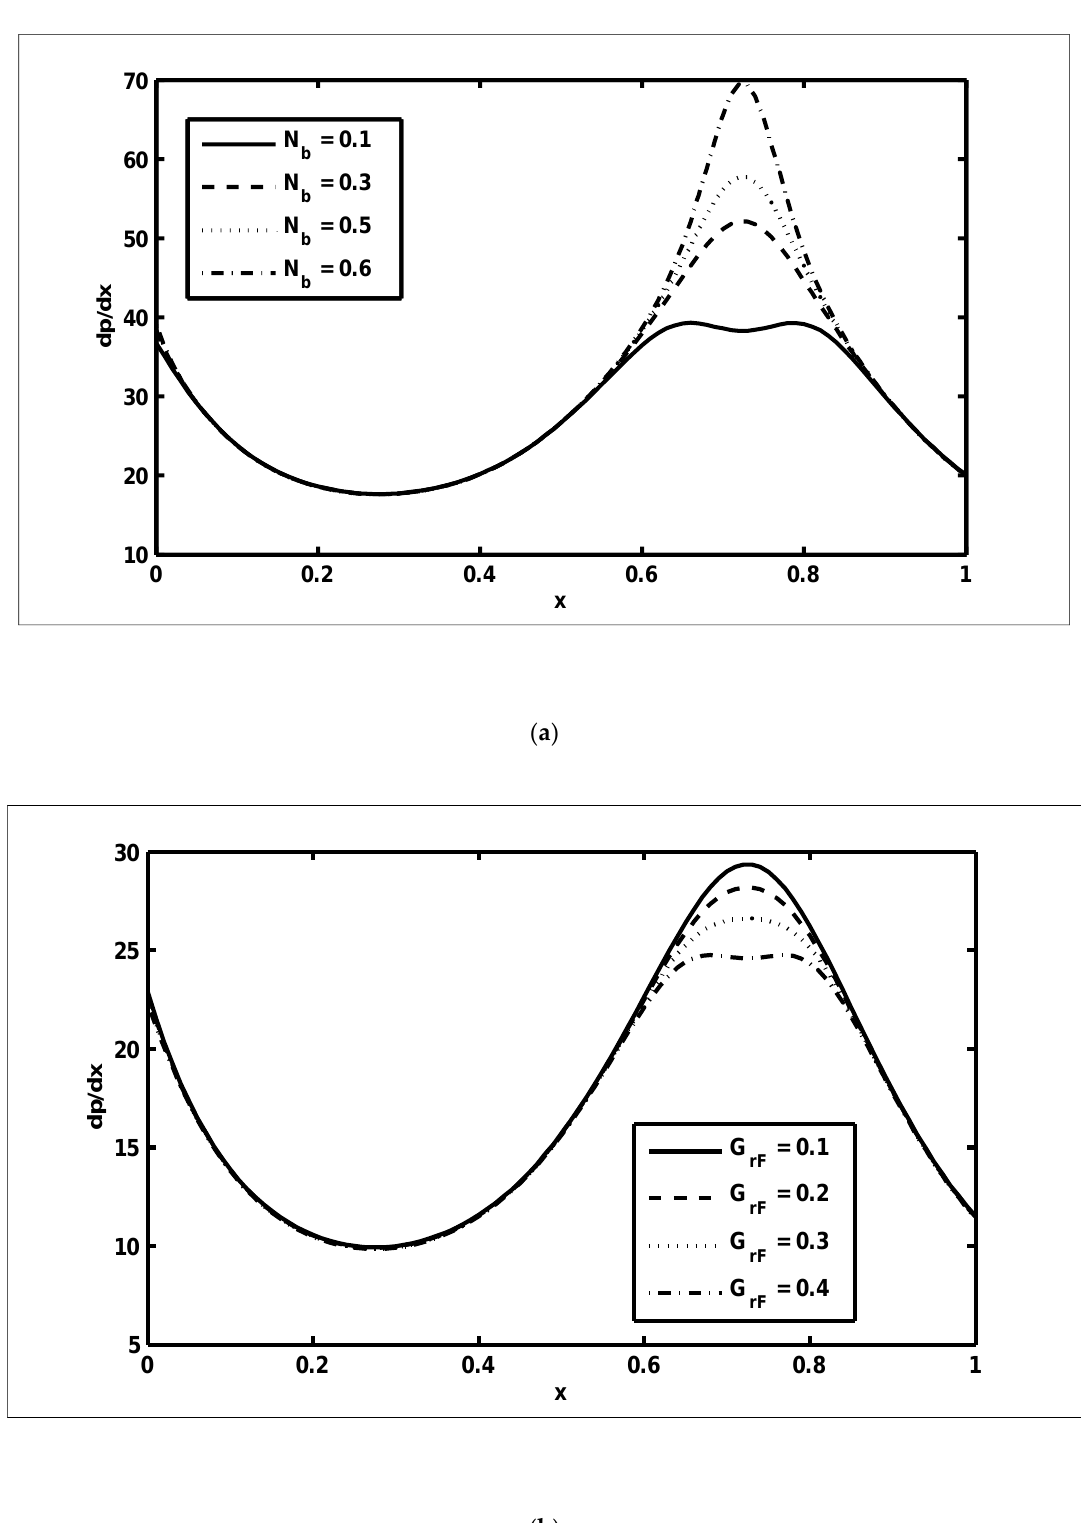
, Γ = 0.8, β = 0.4, m = 0.4, Q = − 5; 6 , Γ = 0.8, 6